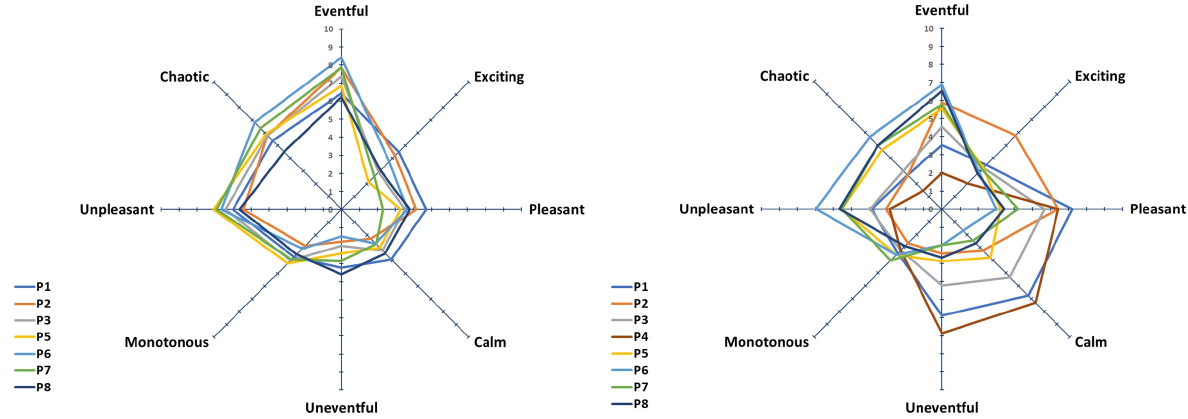
Figure 13: Assessment of emotional components (Q5) at each stop site according to Axelsson et al. model (2010) during SW_M (left) and SW_E (right)